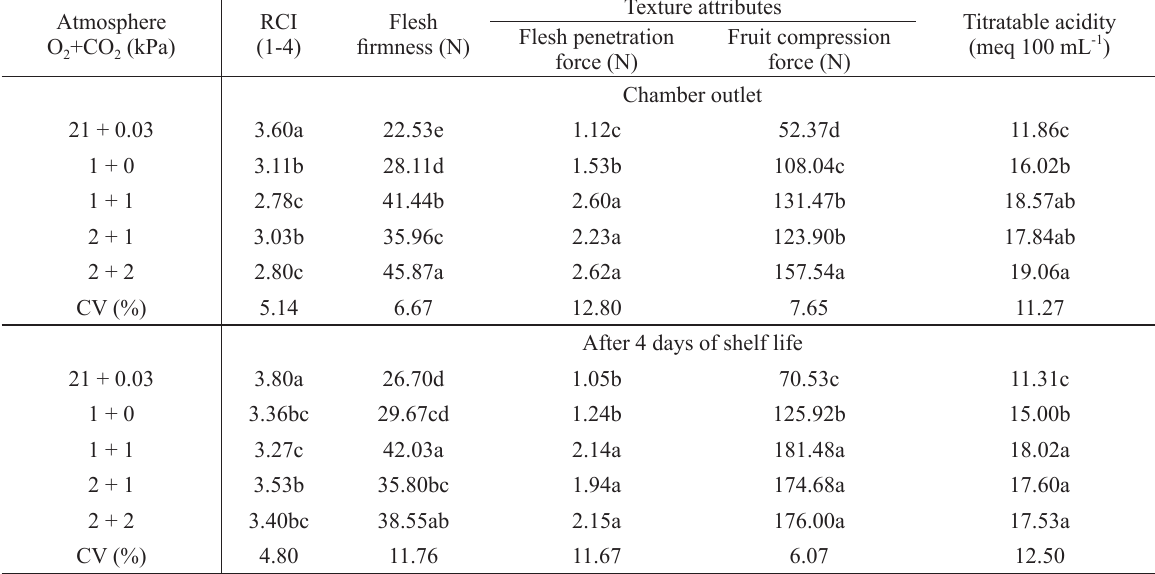
Red color index (RCI), flesh firmness, texture attributes and titratable acidity in ‘Laetitia’ plums stored at 0.5 ° C under different atmospheres for 60 days and four additional